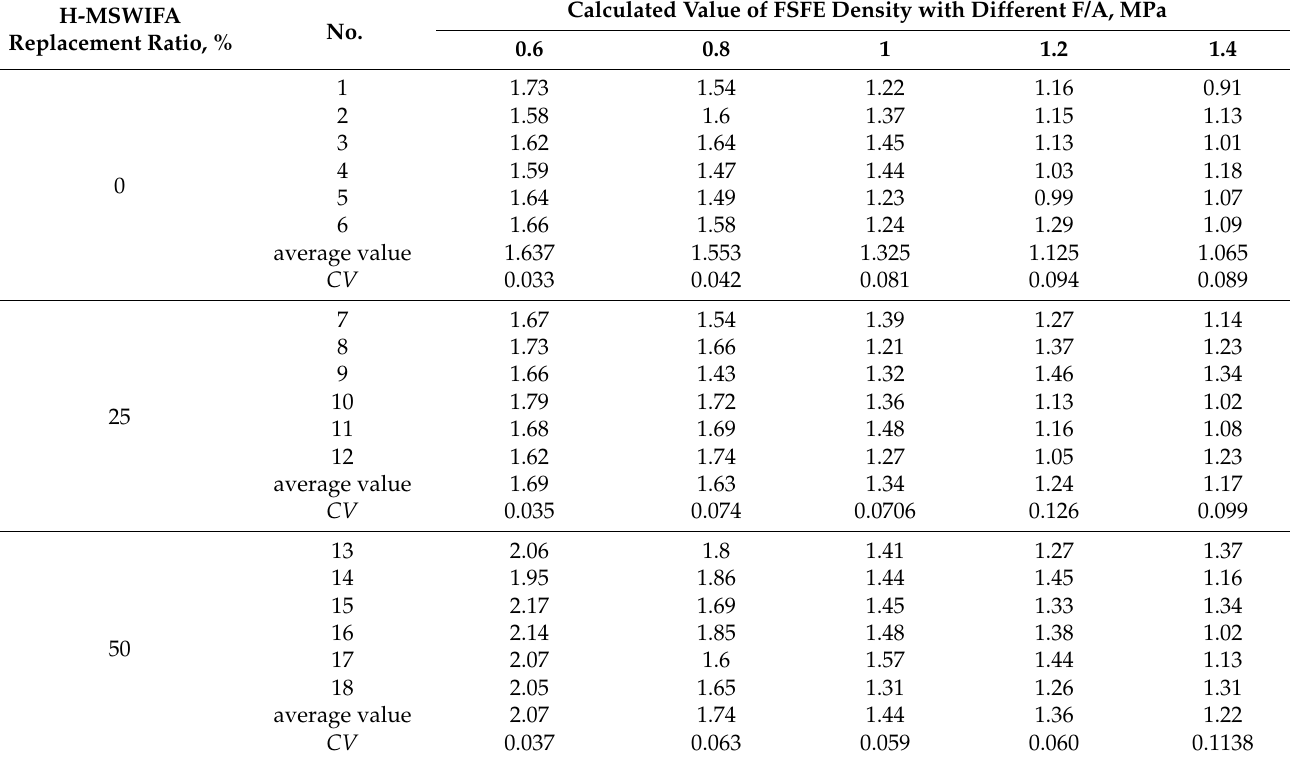
Table 6. Table 6. FSFE results of asphalt Table 6. FSFE results of asphalt mastics.